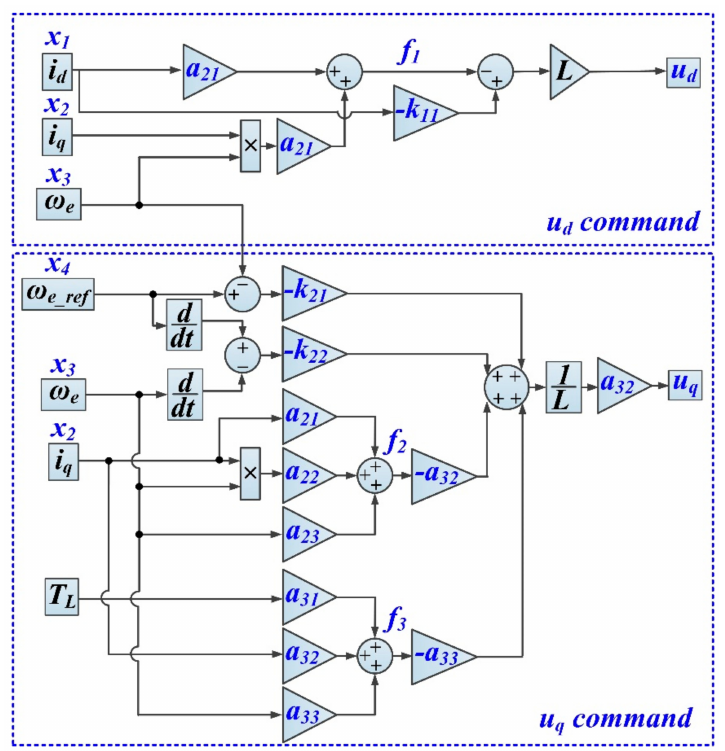
Figure 4. Schematic representation FL controller: u d and u q commands.